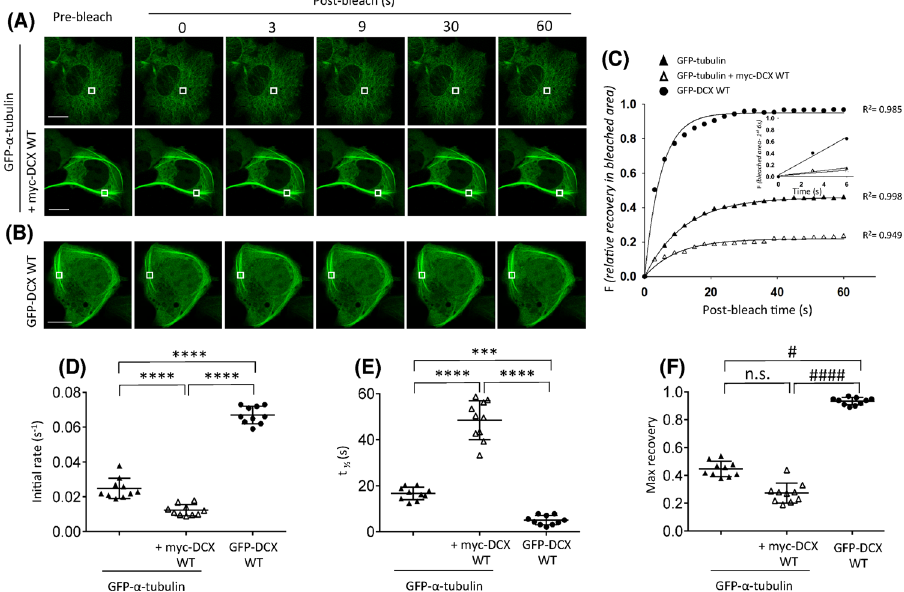
Figure 1. Quantitative FRAP analysis reveals a dynamic association of Doublecortin X (DCX) with stable MT bundles. COS-1 cells were transfected, as indicated, to express GFP-tagged α -tubulin only (upper panels in A), to co-express GFP- α -tubulin together with myc-DCX full-length (wild-type, WT) (lower panels in A) or to express GFP-DCX WT only ( B ). ( A and B ) Representative images are shown for quantitative assessments of tubulin or DCX exchange dynamics. A small ROI (indicated by the white rectangle in each cell image) was photobleached and the fluorescence recovery was subsequently monitored post-bleach at 3 s intervals for 60 s for GFP- α -tubulin ( A ) or GFP-DCX WT ( B ). ( C ) The quantitative recovery of fluorescence in each bleach area was determined; regression values (R 2 ) of the respective curve fits are indicated. The inset highlights the initial recovery of fluorescence in the photobleached area for first three time-points (0–6 s of post-bleach) with the line of best fit used for the calculation of the initial recovery rate. ( D – F ) Pooled quantitative parameters derived from the FRAP data. The recoveries of fluorescence for GFP- α -tubulin, GFP- α -tubulin + myc-DCX WT and GFP-DCX WT over time were analysed. Results are the mean ± SEM for ( D ) the initial rate of recovery of fluorescence for GFP-tubulin or GFP-tubulin + myc-DCX WT and GFP-DCX WT in the bleached area (estimated over the initial 6 s post-bleach as per panel C inset), ( E ) the time to reach half-maximal recovery of fluorescence (t 1/2 ) (estimated as per the curve fit in panel C) and ( F ) the fluorescence fractional maximum recovery in the bleached area (where 1.0 represents full-recovery). Error bars represent the standard error of the means and asterisks and hash symbols indicate values calculated as statistically significantly different for the indicated comparisons for parametric and non-parametric analysis, respectively ( *** p ≤ 0.001, **** p ≤ 0.0001 and # p ≤ 0.05, #### p ≤ 0.0001 n = 10 cells in each of the three independent experiments. n.s. = not significant). Scale bars represent 10 µ